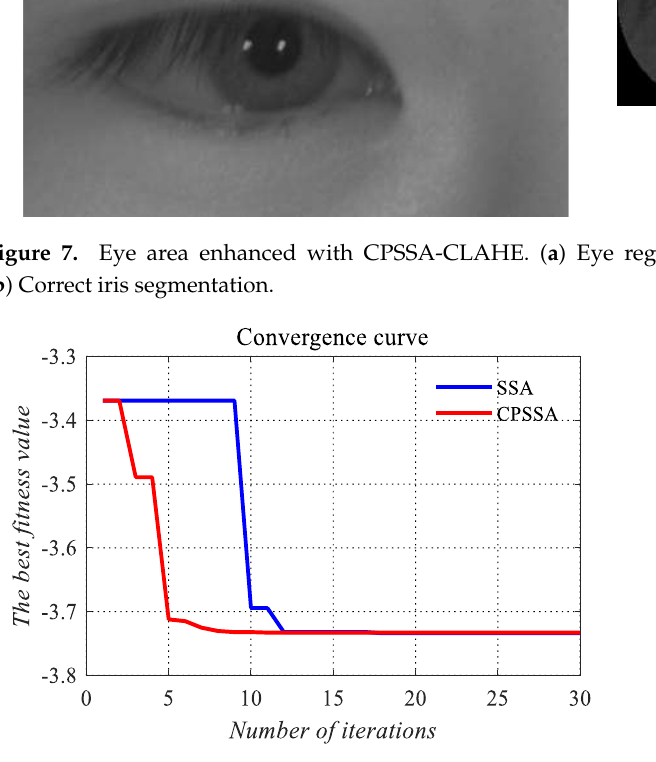
Figure 8. The best results of CPSSA and